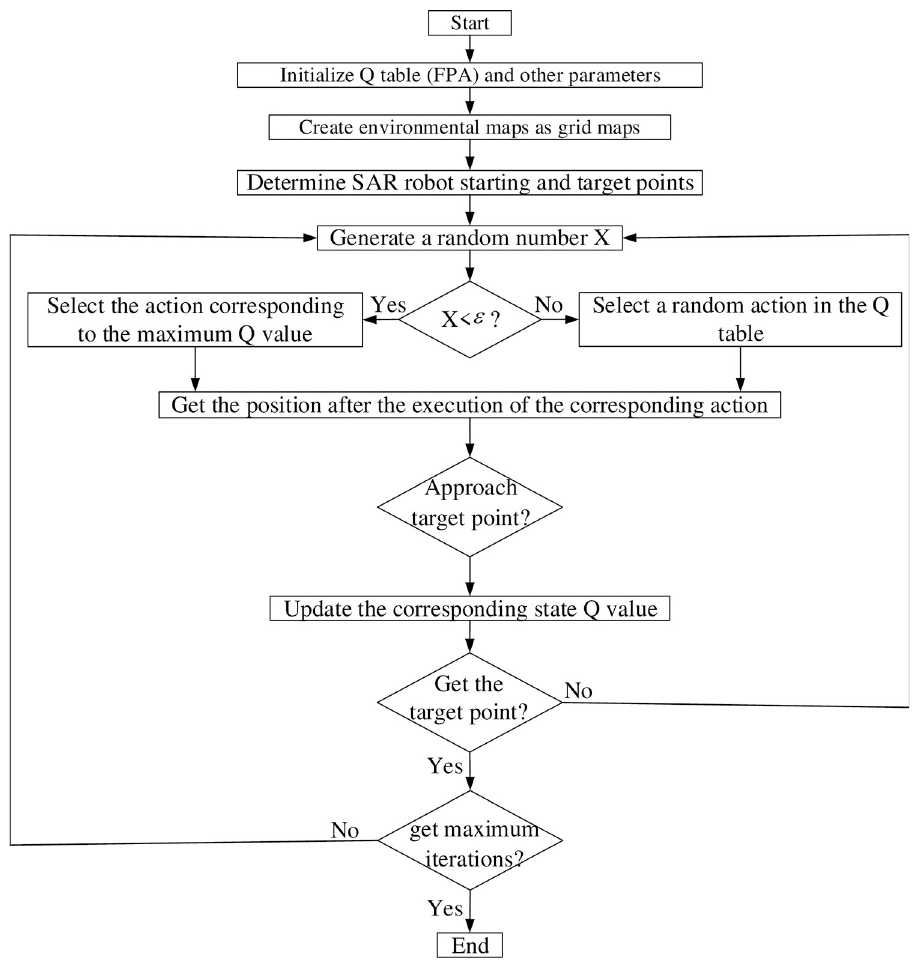
Fig 6. SAR robot search overall